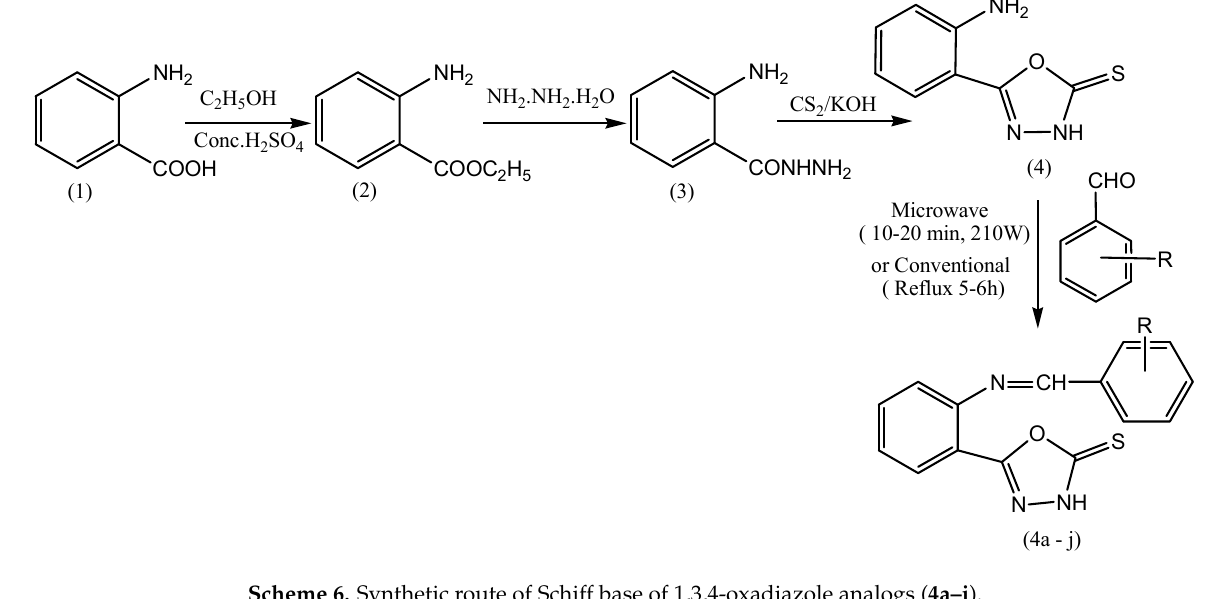
Scheme 6. Synthetic route of Schiff base of 1,3,4-oxadiazole analogs ( 4a–j